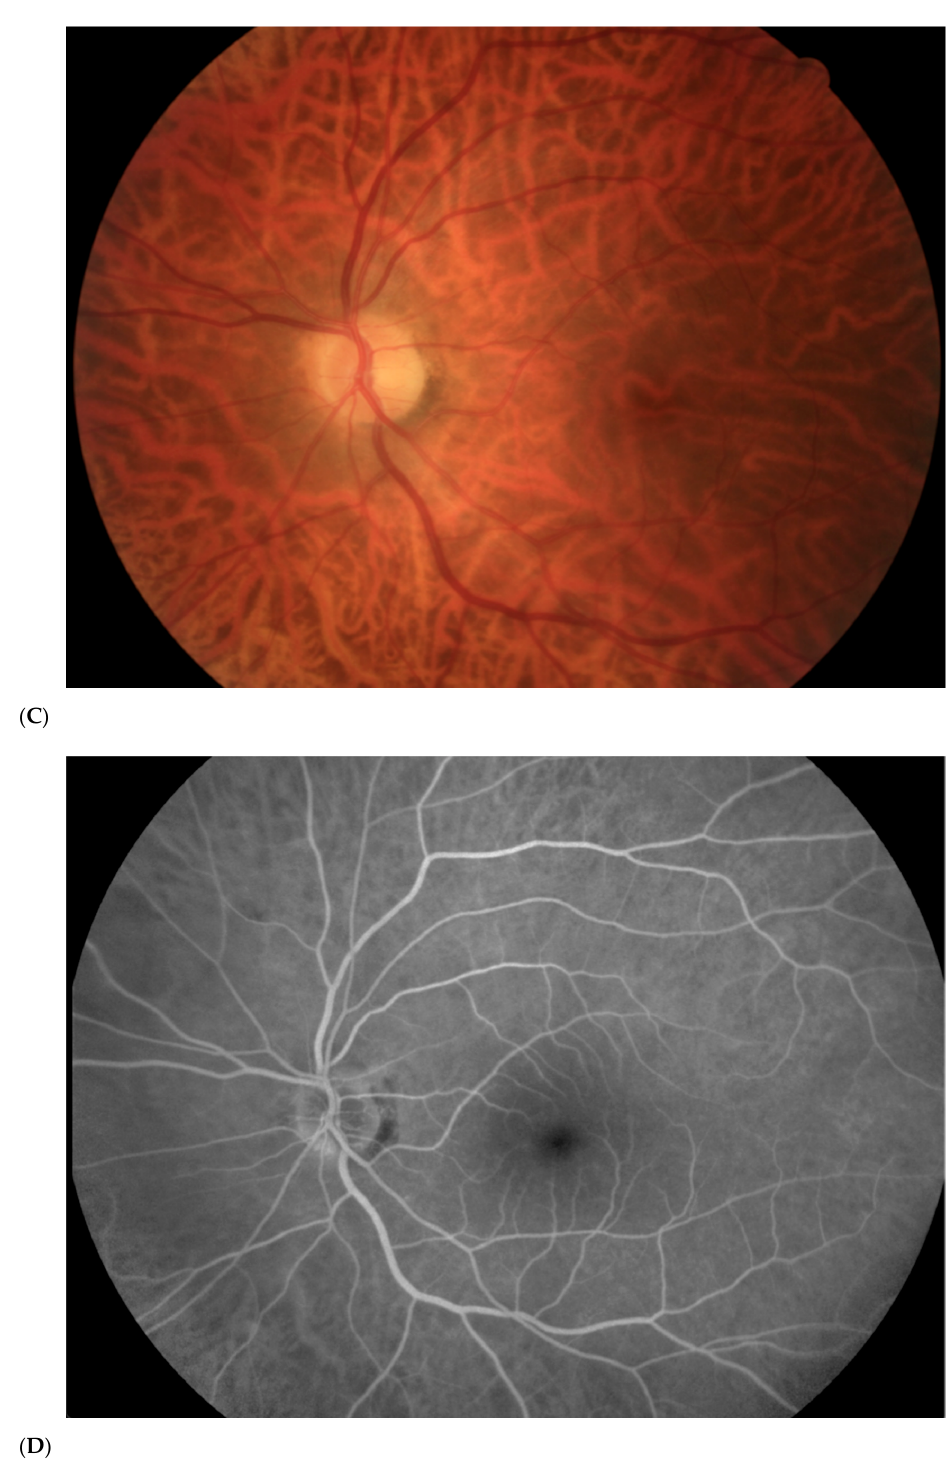
Figure 2. Color fundus photograph ( A ) and late phase fluorescein angiogram ( B ) of the left eye of a 60-year-old diabetic woman with West Nile neuroinvasive disease, showing multifocal chorioretinitis with the typical linear clustering of the chorioretinal lesions (arrows). Fluorescein angiography allows a more precise delineation of the chorioretinal lesions. Note the presence of associated retinal vascular sheathing (arrowheads) and non-proliferative diabetic retinopathy and diabetic maculopathy with macular hemorrhages and hard exudates (asterisks). Fundus photograph ( C ) and fluorescein angiogram ( D ) of an age-matched normal patient are provided for